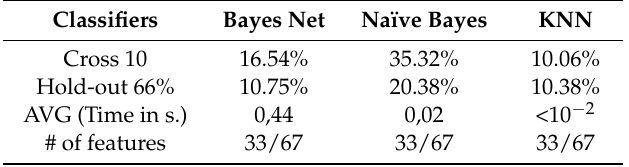
Table 11. Results using Statistical features for IAM Online Handwriting Database.